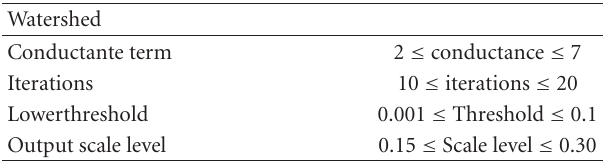
Figure 4: (column K1) Values set for the subdural hygroma ( x ) are conductance = 2 . 5, iterations = 11, lower = 0 . 015, scale level = 0 . 15 by watershed approach. Table 4: Internal constraints for